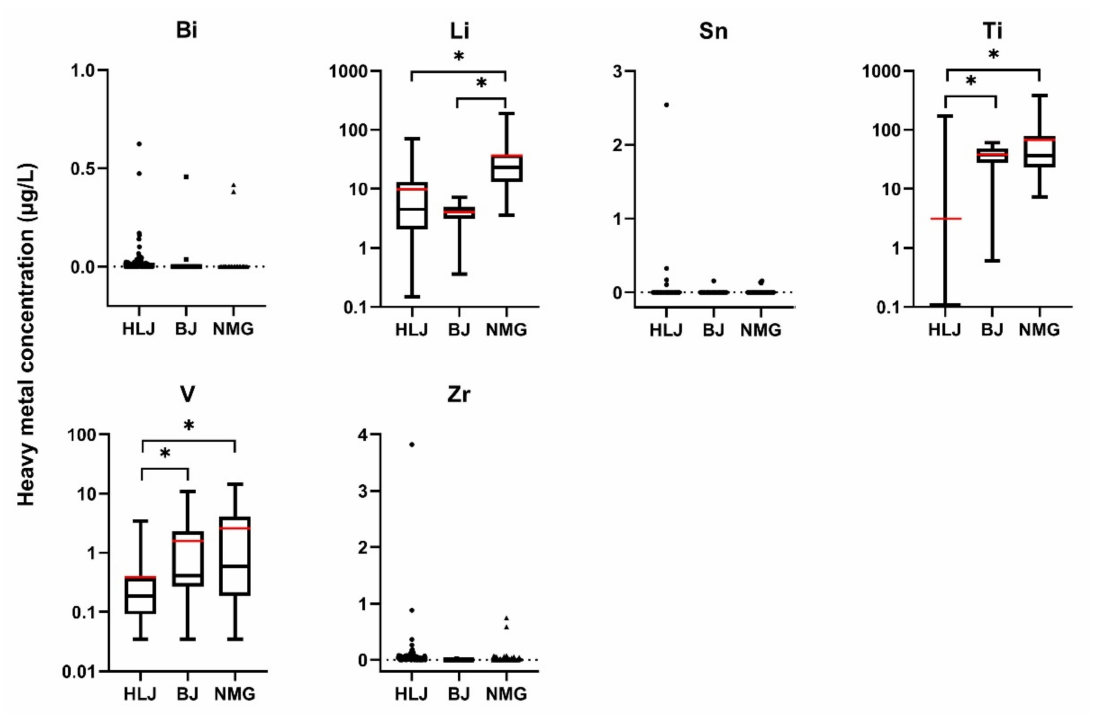
Figure 1. The concentrations of heavy metals in self-supplied wells’ water (elements not mentioned in SDW and WHO). The red line is the average value. * Represents p < 0.05. The average (and maximum) concentrations of Li were 9.80 µ g/L (71.33 µ g/L), 4.07 µ g/L (7.18 µ g/L), and 36.39 µ g/L (191.50 µ g/L) in HLJ, BJ, and NMG,